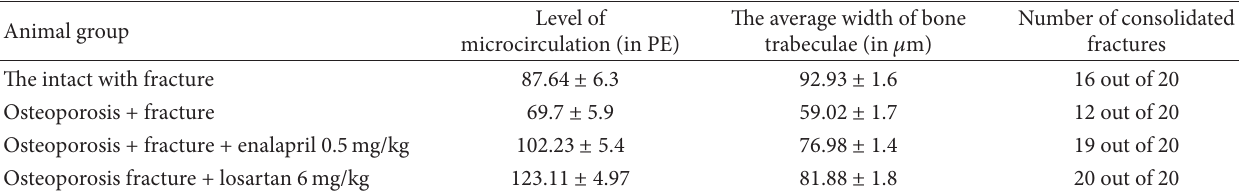
T 2: e average parameters of microcirculation, the width of the bone trabecule in the bony callus and rate of consolidation of the experimental osteoporotic fractures of the proximal part of rats femur, the once received treatment with the studied medication is compared with control